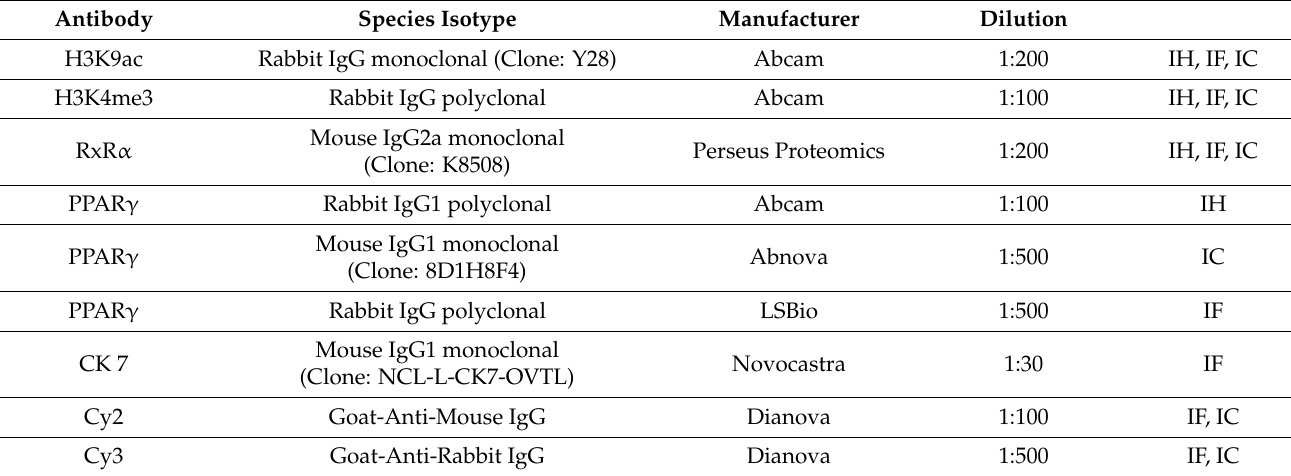
Table 2. Antibodies used in the immunohistochemistry (IH), immunofluorescence (IF) and immunocytochemistry (IC).